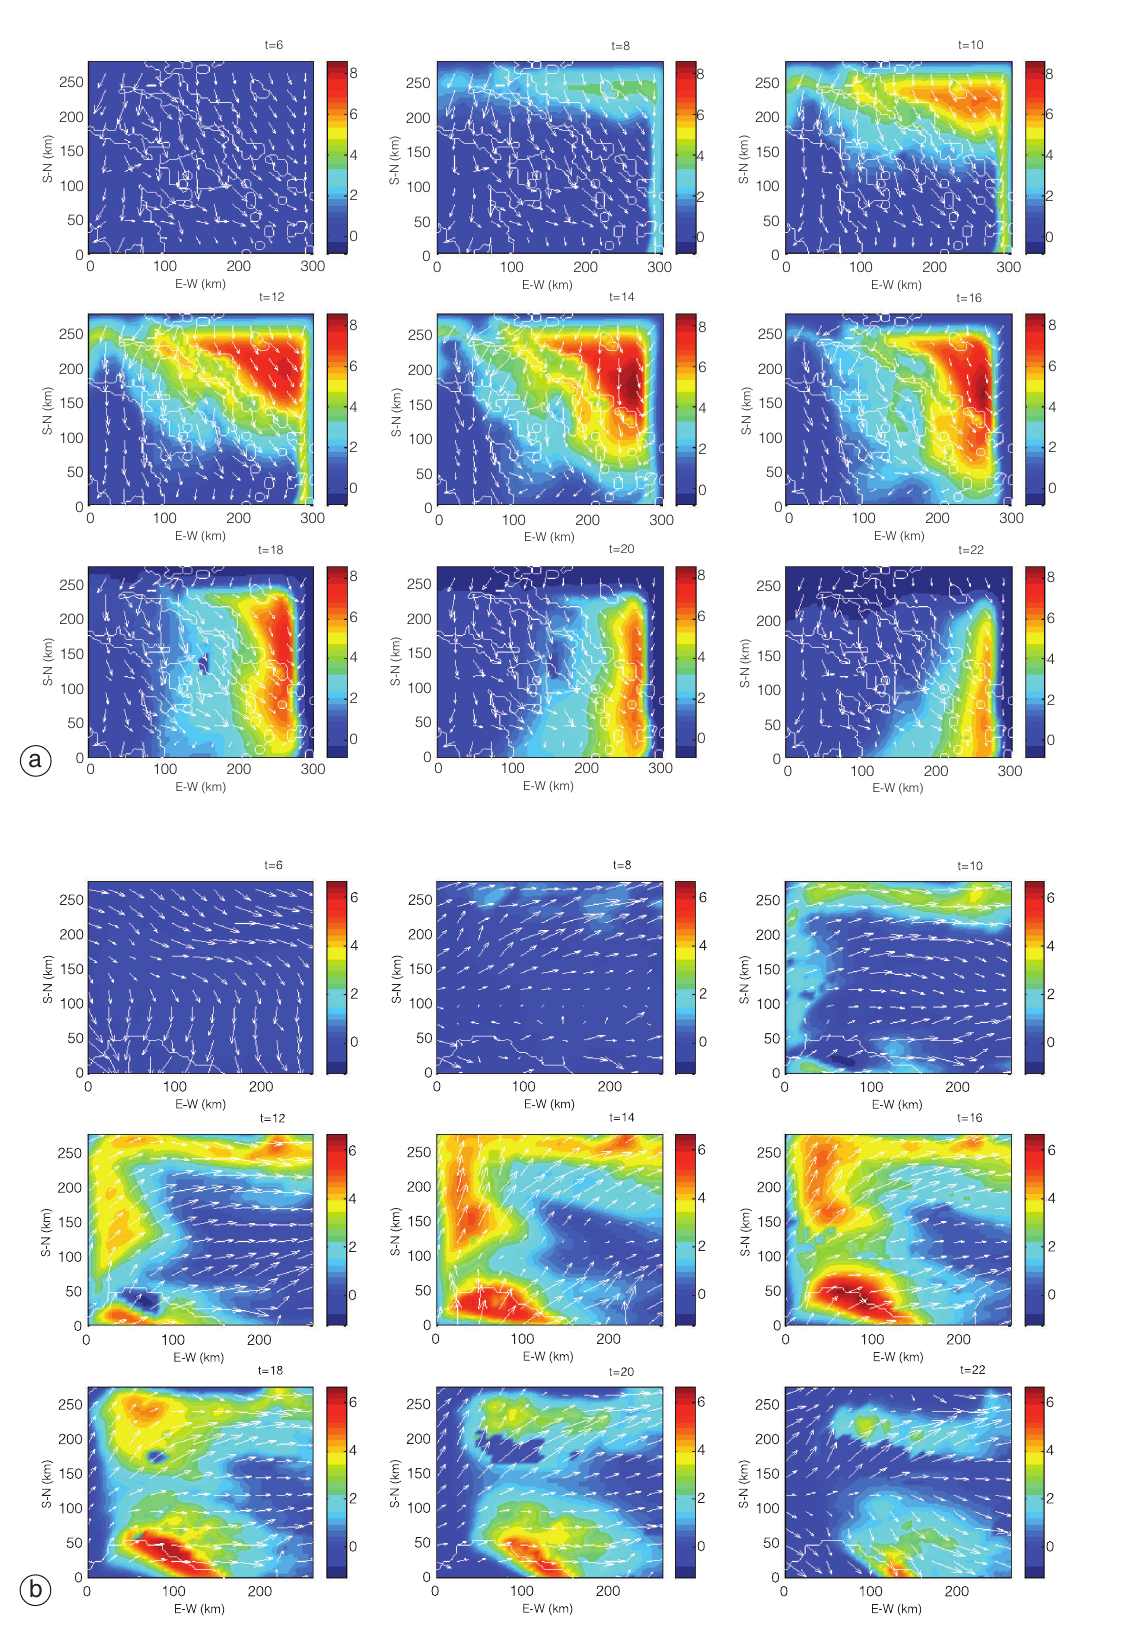
O3 NOX for the domain of: a) Athens; b) 1